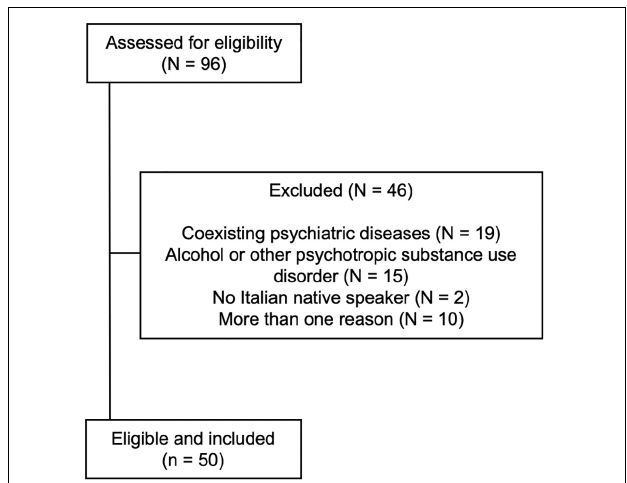
FIGURE 1 | Flow diagram of the study and reasons for patients’ exclusion.